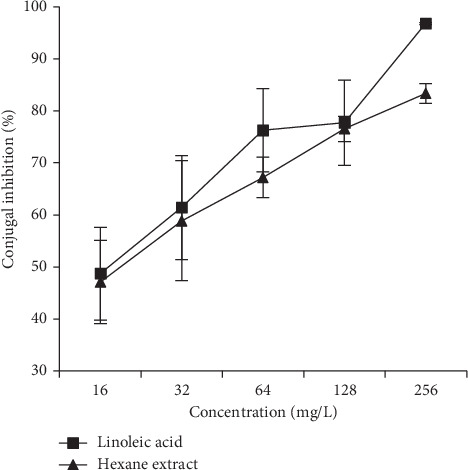
The effect of varying concentrations of hexane extract and the known plasmid transfer inhibitor linoleic acid on the conjugal transfer of the IncW plasmid R7K. The values represent the mean conjugal inhibition frequency ± standard deviation (%).